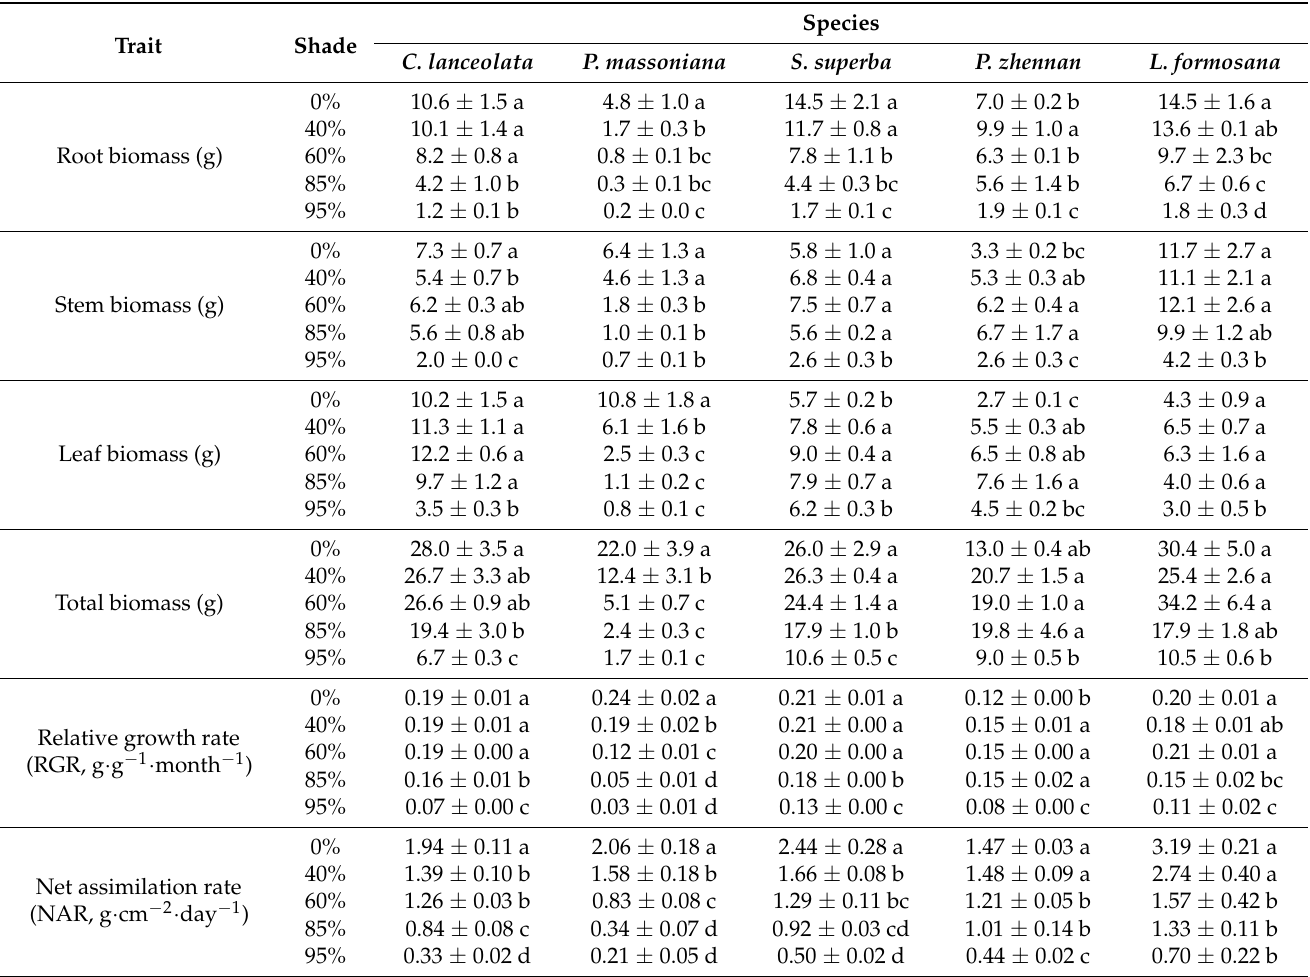
Table 1. Seedling growth characteristics of five tree species under different shade treatments.